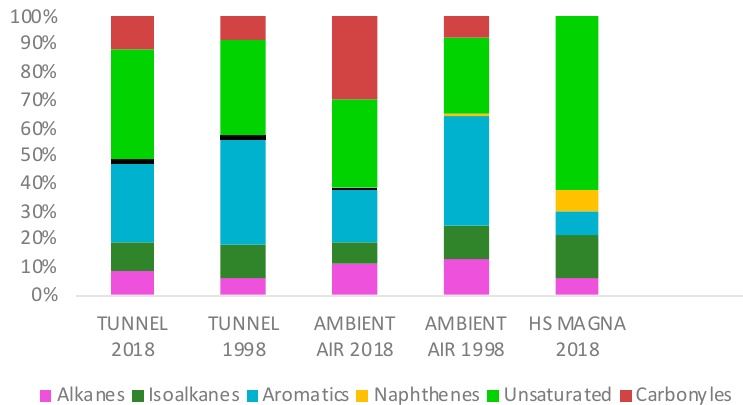
Figure 5. Contribution to ozone formation potential in tunnels and ambient air.